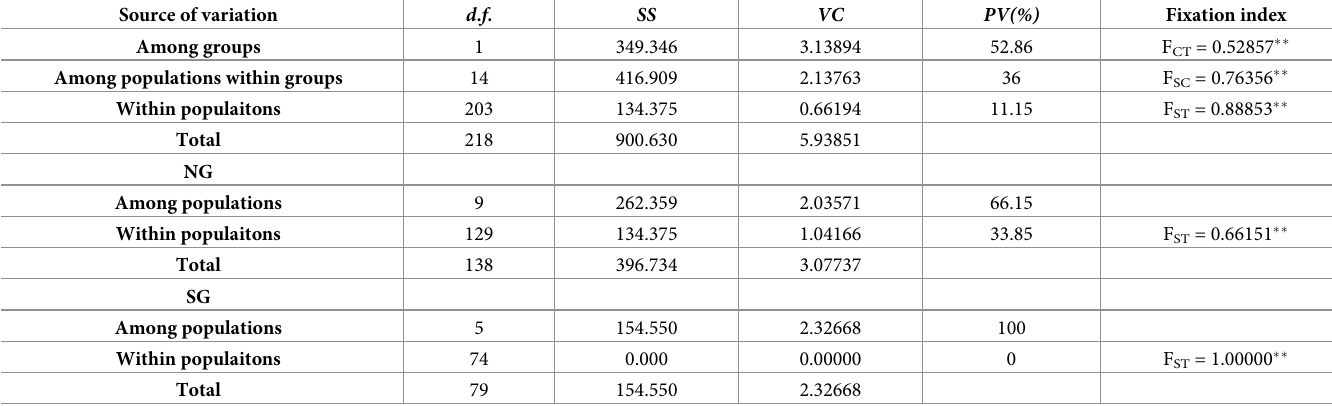
Table 3. Results of analysis of molecular variance of cpDNA sequence data of Tugarinovia mongolica . Source of